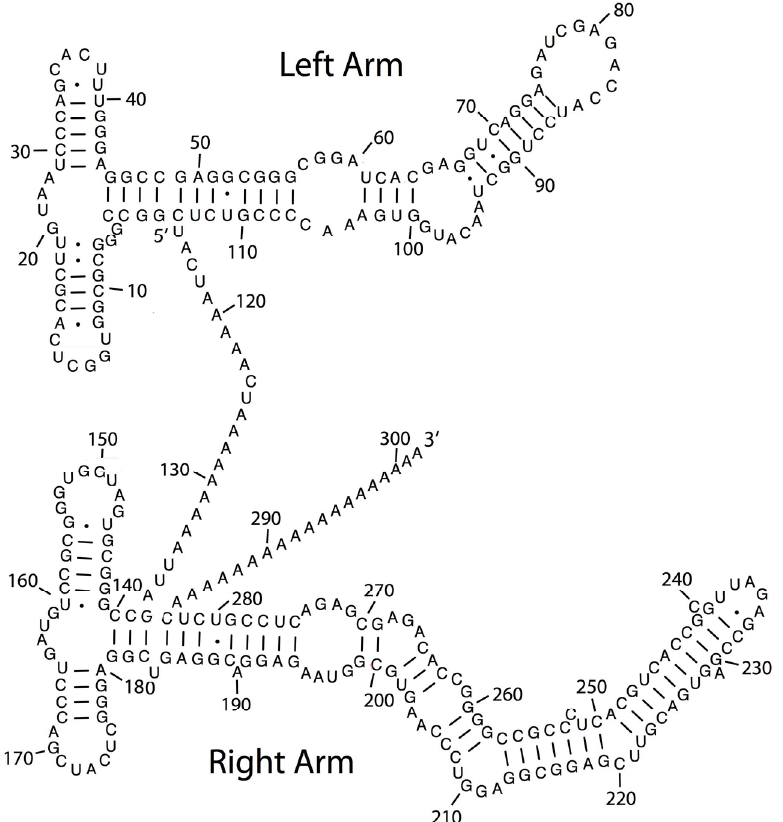
Figure 1. Secondary structural model of Alu RNA. Modified from [15] with permission from Dr. Jennifer